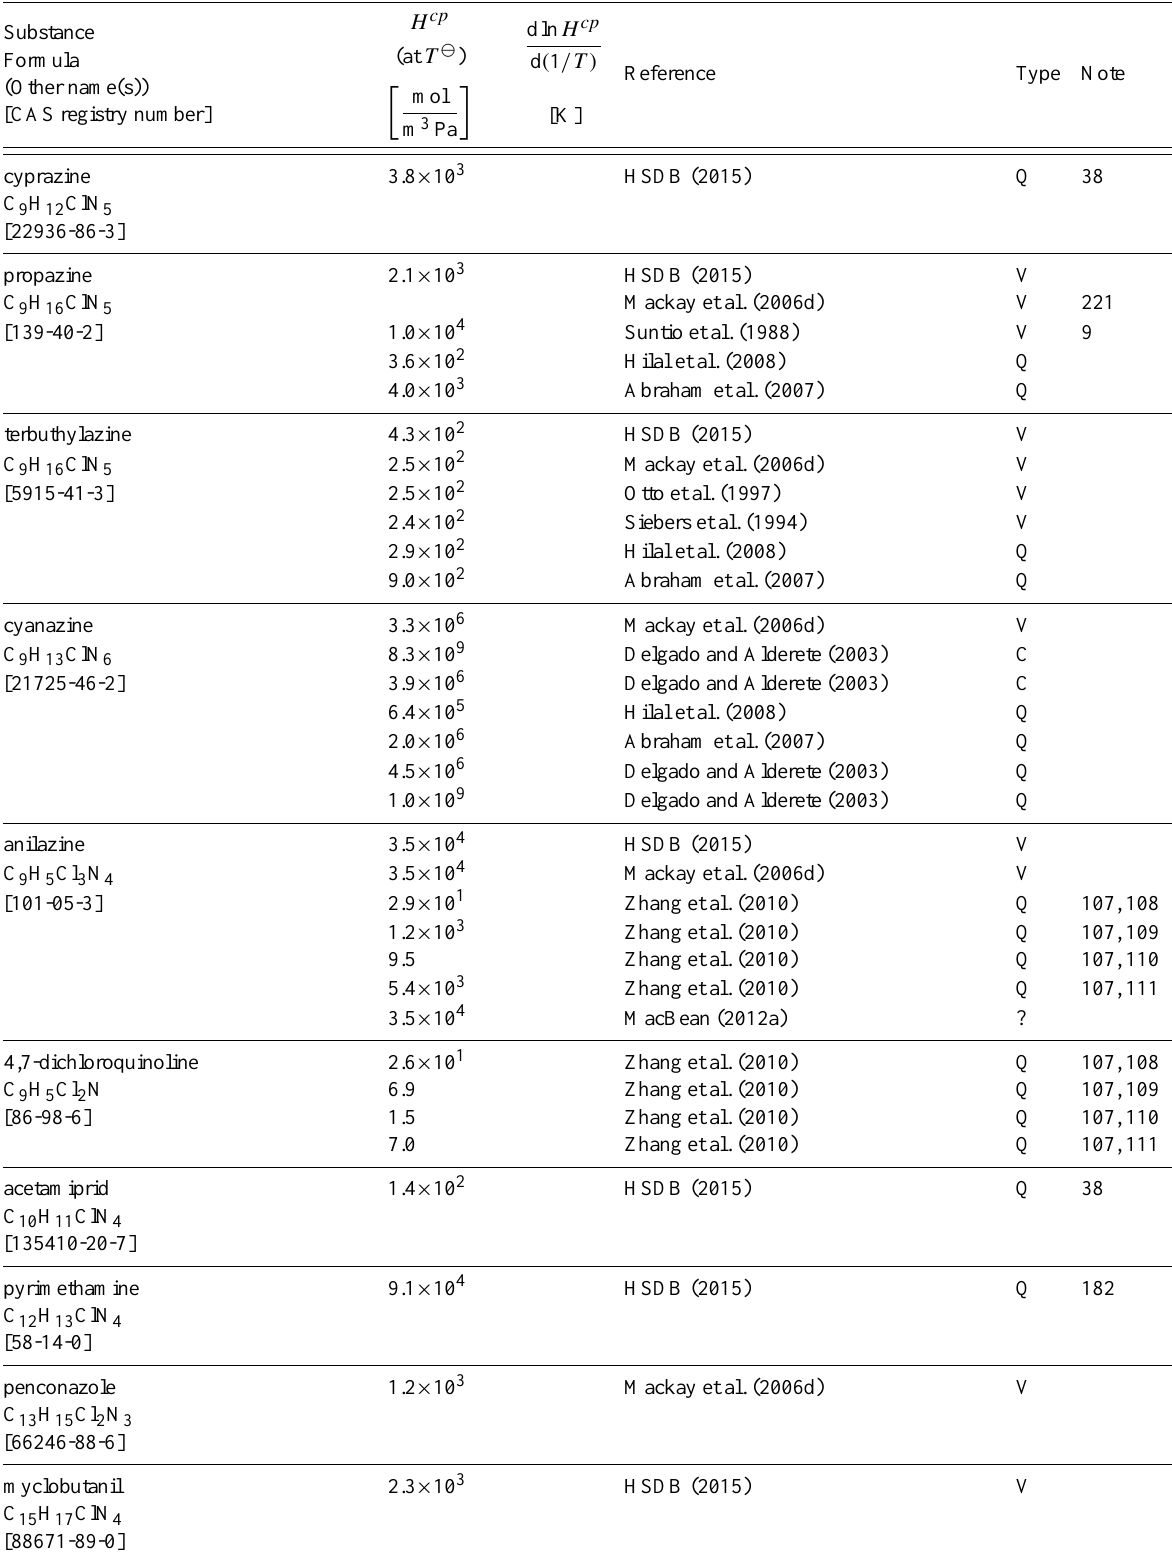
Table 6: Henry’s law constants for water as solvent